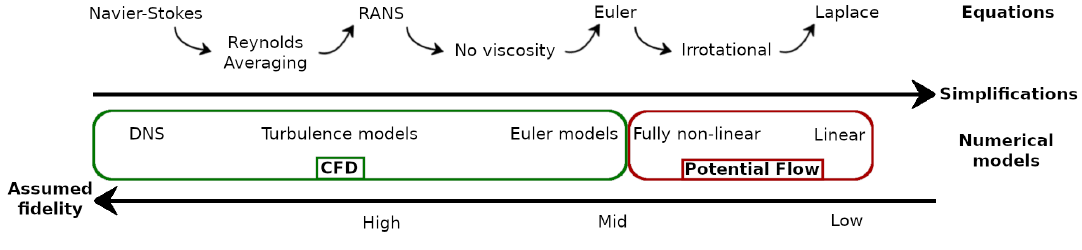
Figure 1. Assumed fidelity of numerical models from the simplifications of Navier–Stokes Equations. Inspired from